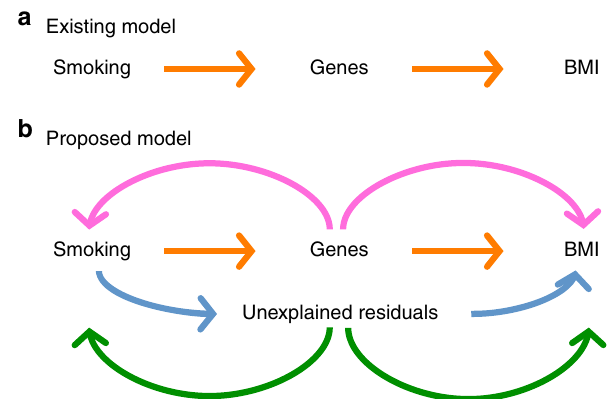
Fig. 1 A simpli fi ed path diagram of the existing and proposed interaction model. a Existing interaction model where smoking modulates genes such that their expression, regulation and effects underlying BMI are changed (genotype – covariate interaction). b Proposed MRNM where genotype – covariate interaction is only a part of the latent mechanism that also includes pleiotropic effects on smoking and BMI (magenta arrow), residual – covariate interaction (blue arrow) and residual correlation (green arrow). Unexplained residuals may be partly due to epigenetic or unknown factors that are not captured by the genetic component, resulting in heterogeneous error (co)variance across different covariate